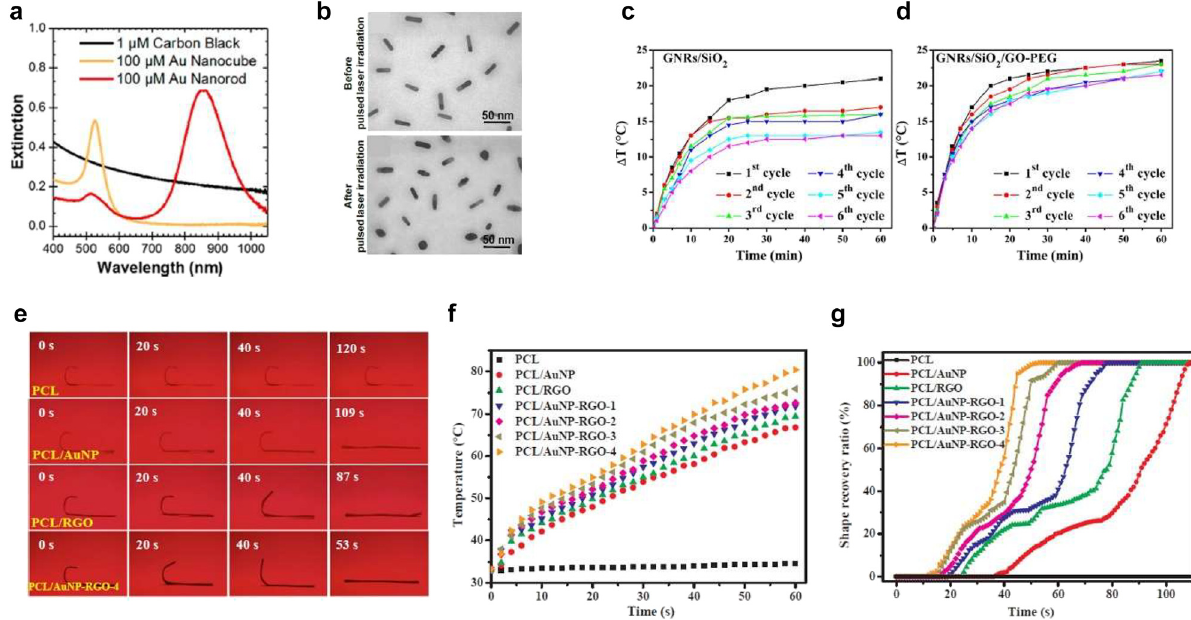
Figure 9: General photothermal method for light activation: hybrid of metal nanoparticles and carbon nanomaterials. (a) Extinction spectra of carbon black, gold nanocubes, and gold nanorods. Gold nanoparticles have distinct extinction peaks, while